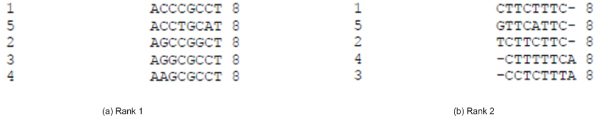
Edit distance cluster for unidirectional promoters. Sequence logos corresponding to the word-based clusters of the top 2 overrepresented words of the unidirectional promoters. Rank 1 (a) is corresponding to the word ACCCGCCT, while Rank 2 (b) refers to CTTCTTTC.